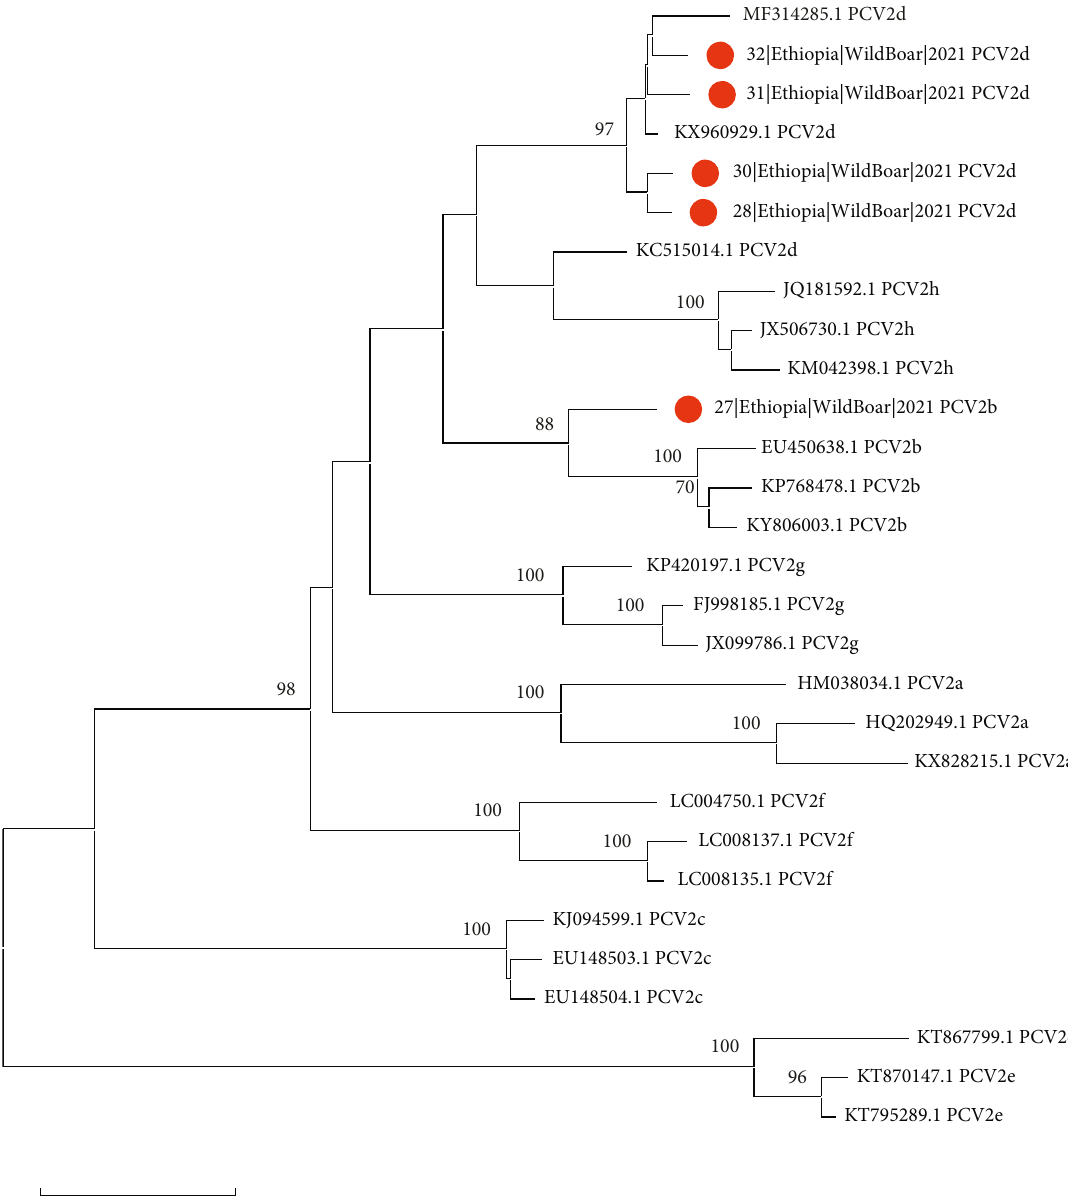
Figure 1: Neighbor-joining phylogenetic tree depicting the relationship between strains sequenced in the present study and the set of reference sequences suggested by Franzo and Segales [15]. The bootstrap support, when higher than 70, is reported nearby the corresponding